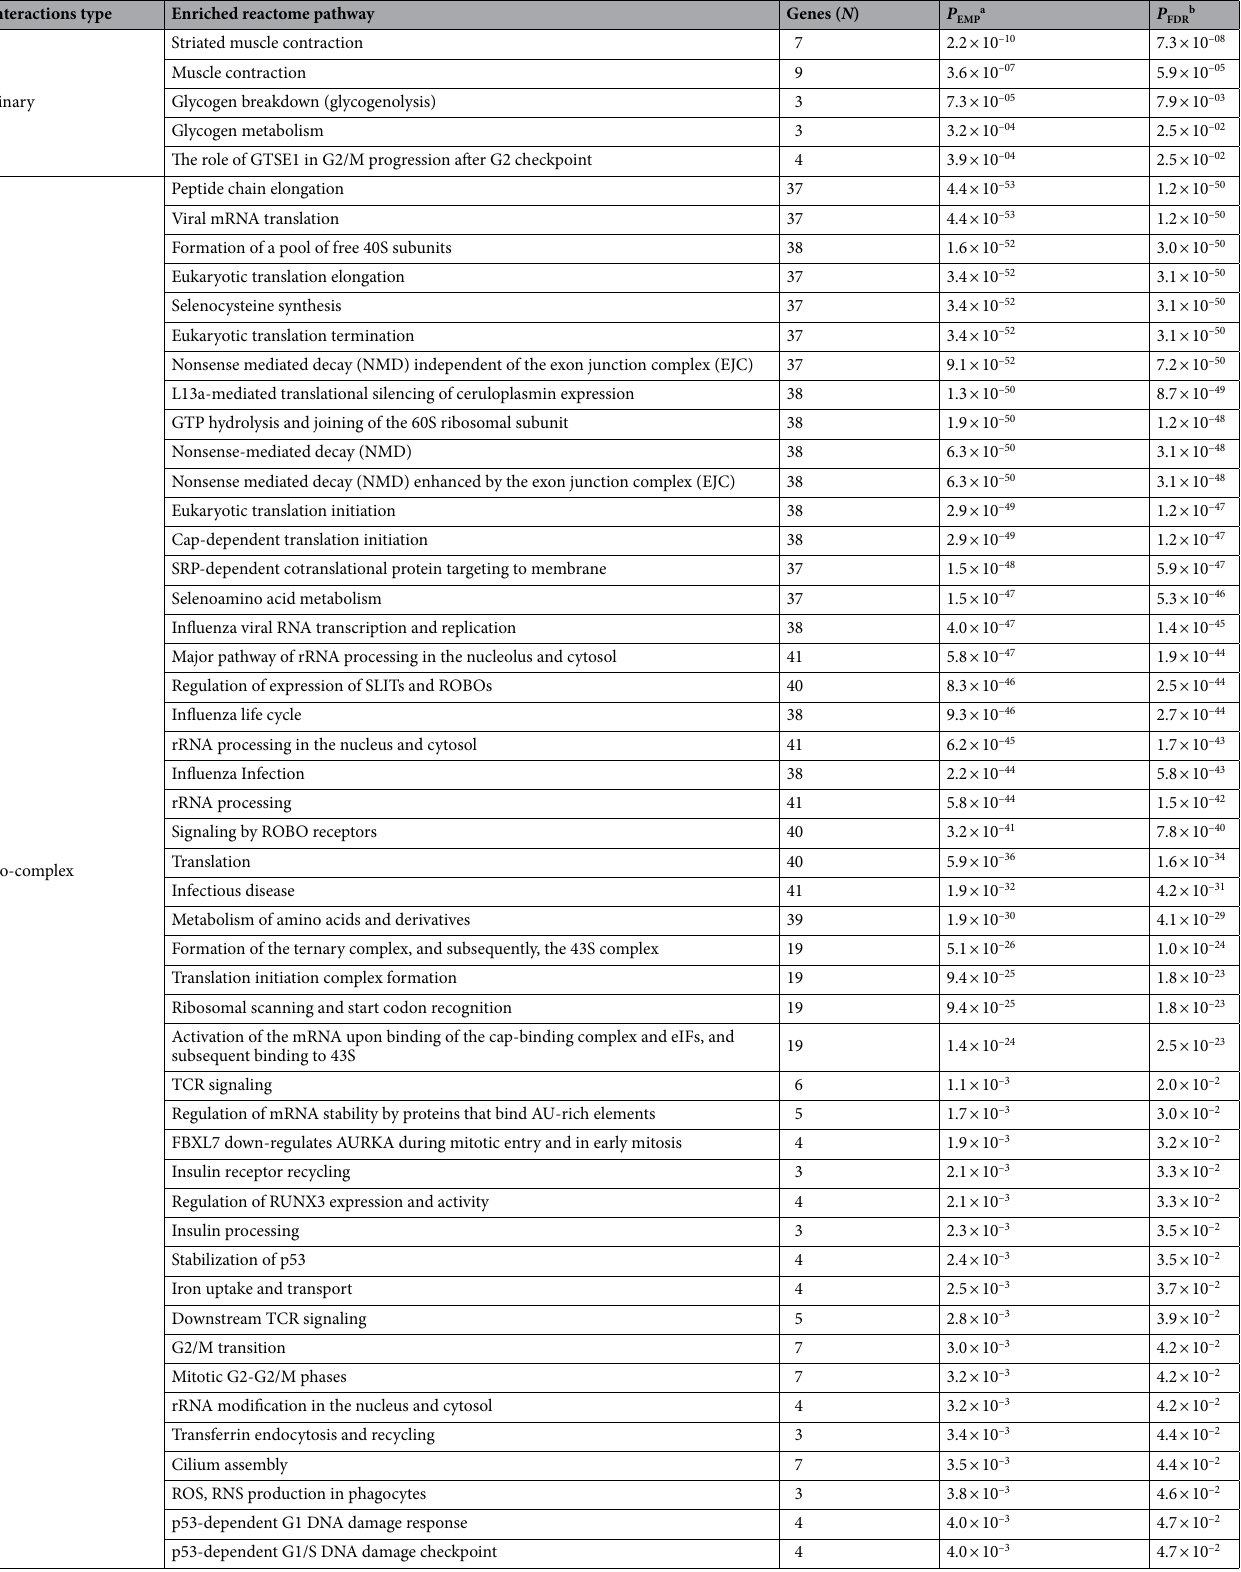
Table 4. Reactome pathways enriched with genes involved in the top 1% subnetworks obtained when considering binary and co-complex interactions. a Empirical p-value of the association test with DTC risk at the pathway level. b p-value of the association test with DTC risk at the pathway level, after FDR